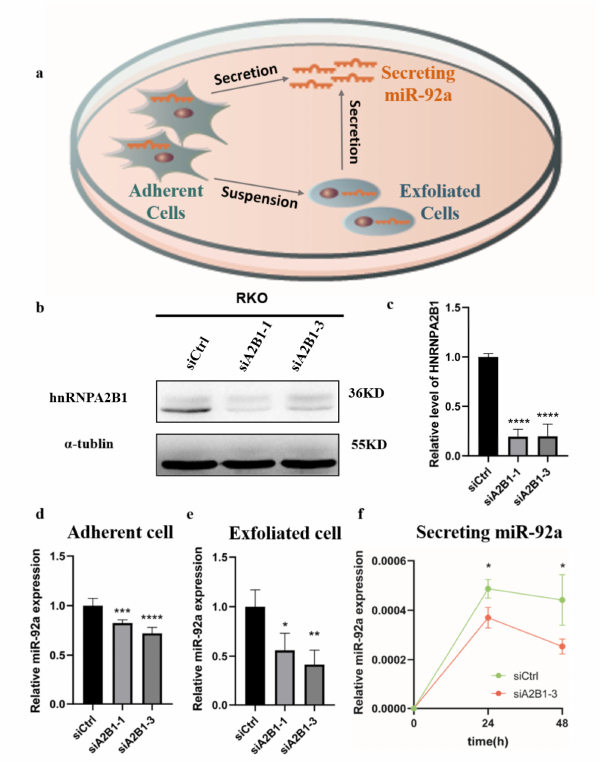
Figure 5. In vitro experiments confirmed that HNRNPA2B1 may regulate the expression and secretion of miR-92a. ( a ) Pattern diagram: the adherent cells, exfoliated cells, and secreting miR-92a in the culture dish were detected, respectively, for RKO cell line; ( b ) HNRNPA2B1 expression was successfully knocked down by si-HNRNPA2B1 transfection for 48 h in RKO cells; ( c ) HNRNPA2B1 expression in adherent CRC cells with or without HNRNPA2B1 knockdown was measured by qRT-PCR ( n = 3); ( d – f ) miR-92a expression from adherent cells, exfoliated cells, and secreting in culture medium with or without HNRNPA2B1 knockdown ( n = 3), respectively. * p < 0.05; ** p < 0.01; *** p < 0.001; **** p <